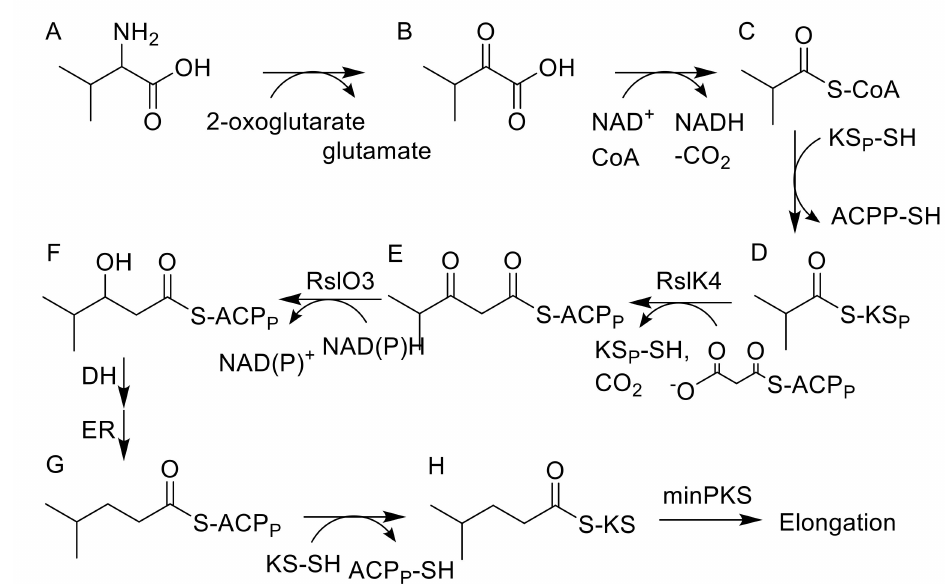
Figure 3. Proposed biosynthesis of the starter unit for rishirilide biosynthesis. ( A )